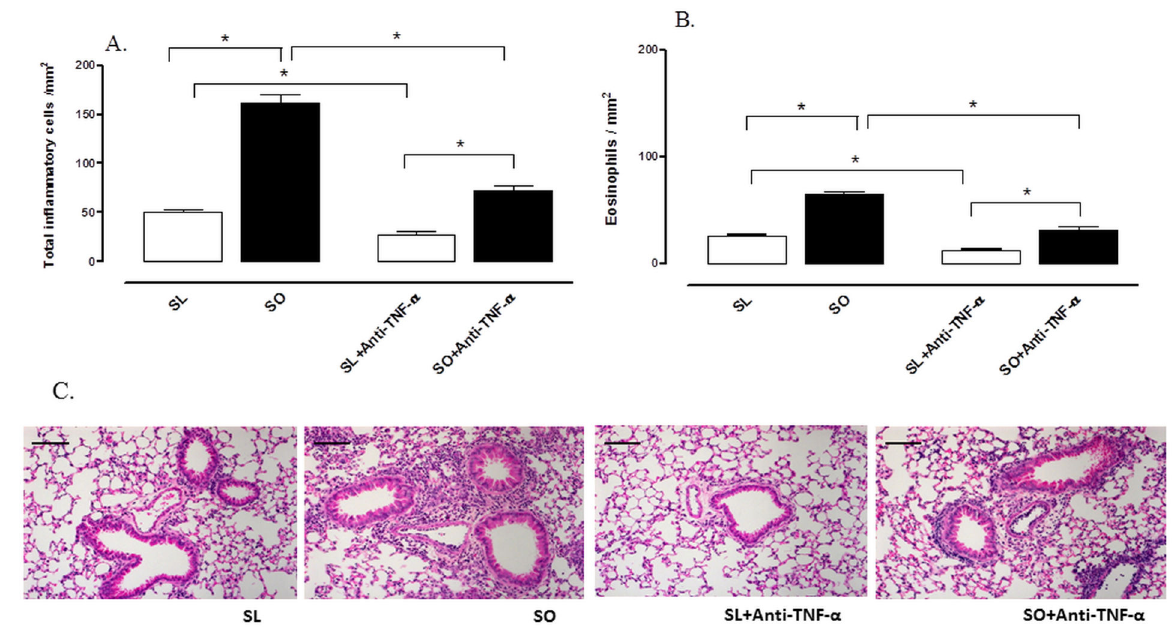
Figure 9. Effect of monoclonal anti-TNF-α antibody treatment (2 mg/kg) on the number of total inflammatory cells (A) and eosinophils (B) in lung connective tissue surrounding the bronchial and bronchiolar segments at 48 h following intranasal challenge with ovalbumin in sensitized mice. Anti-TNF-α antibody was given intraperitoneally at days 14 and 15 and 1 h before the first ovalbumin challenge. Representative high-power fields of bronchiolar structures from the following groups: sensitized lean (SL), sensitized obese (SO), sensitized lean treated with anti-TNF-α (SL + anti-TNF-α) and sensitized obese treated with anti-TNF-α (SO + anti-TNF-α). Panel C shows representative images of lung histology for the four experimental groups. Each column represents mean ± SEM (n = 6) of the number of cells mm 2 . Haematoxylin–eosin, high magnification (bar represents 20 µm).